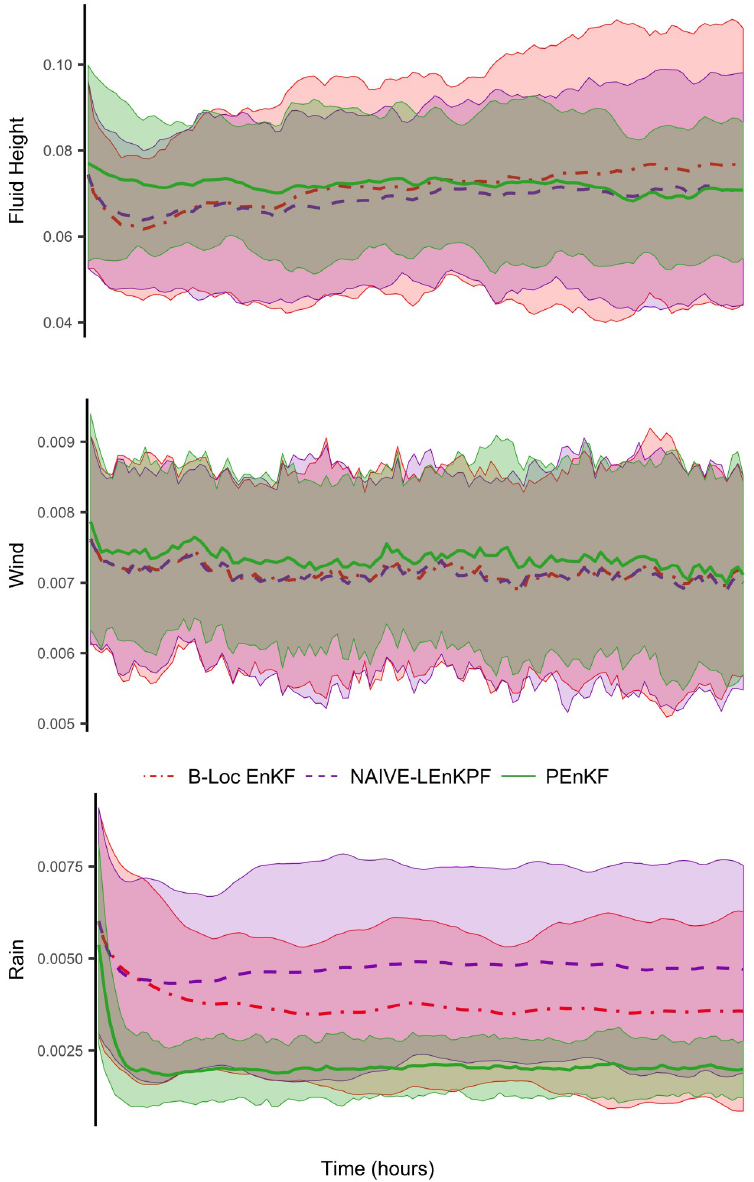
Fig 4. The RMSE of the B-Loc EnKF, NAIVE-LEnKPF, and PEnKF over 50 trials. The darker lines of each linetype are the mean and the colored areas are the 95% confidence intervals. All three filters are pretty indistinguishable except for the PEnKF’s rain error, which is statistically smaller than the